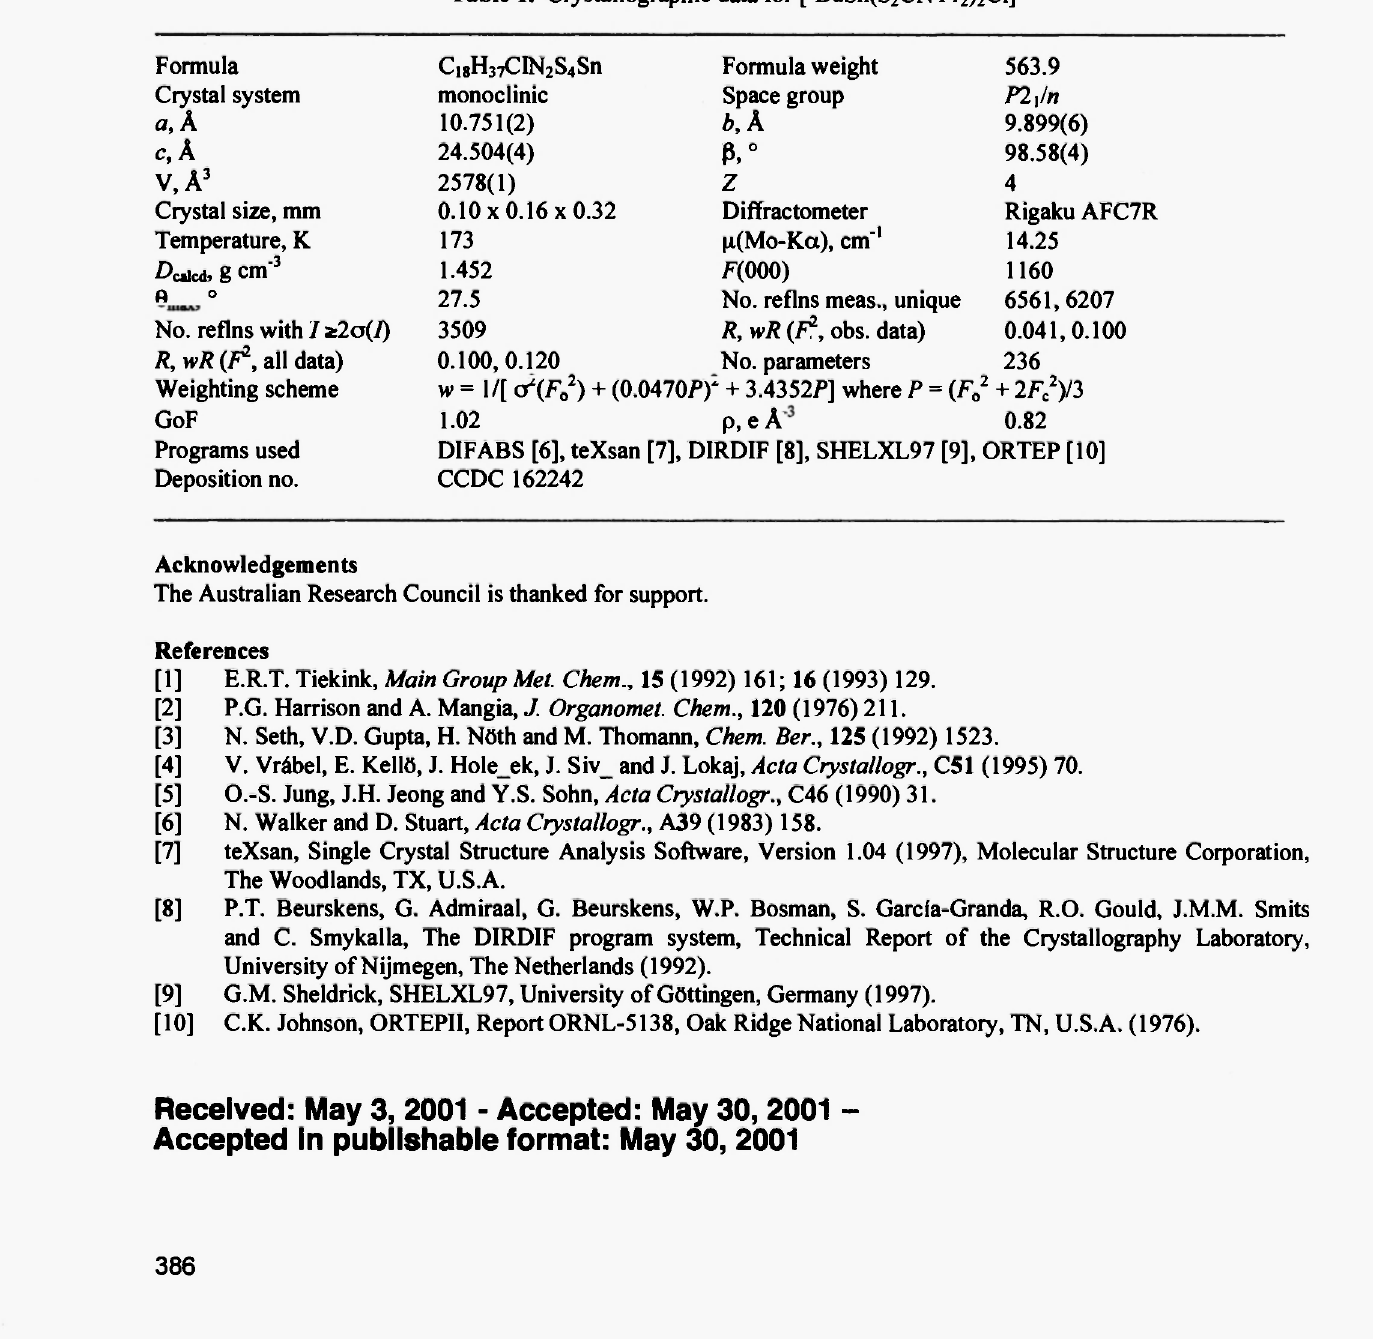
Table 1. Crystallographic data for [ n BuSn(S